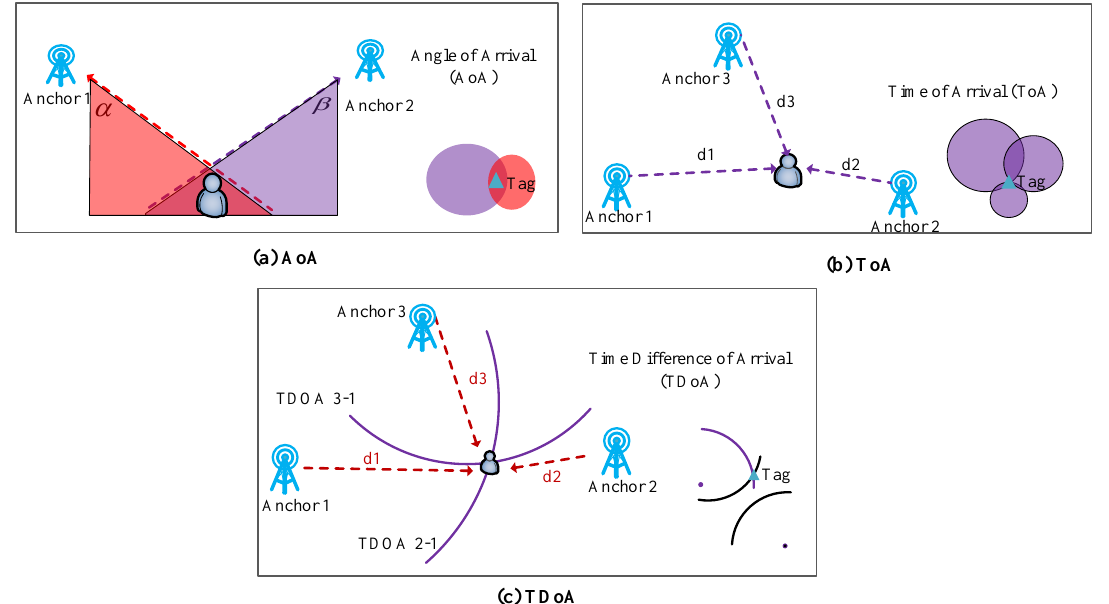
Figure 2. The fundamentals of acoustic and radio wave positioning .